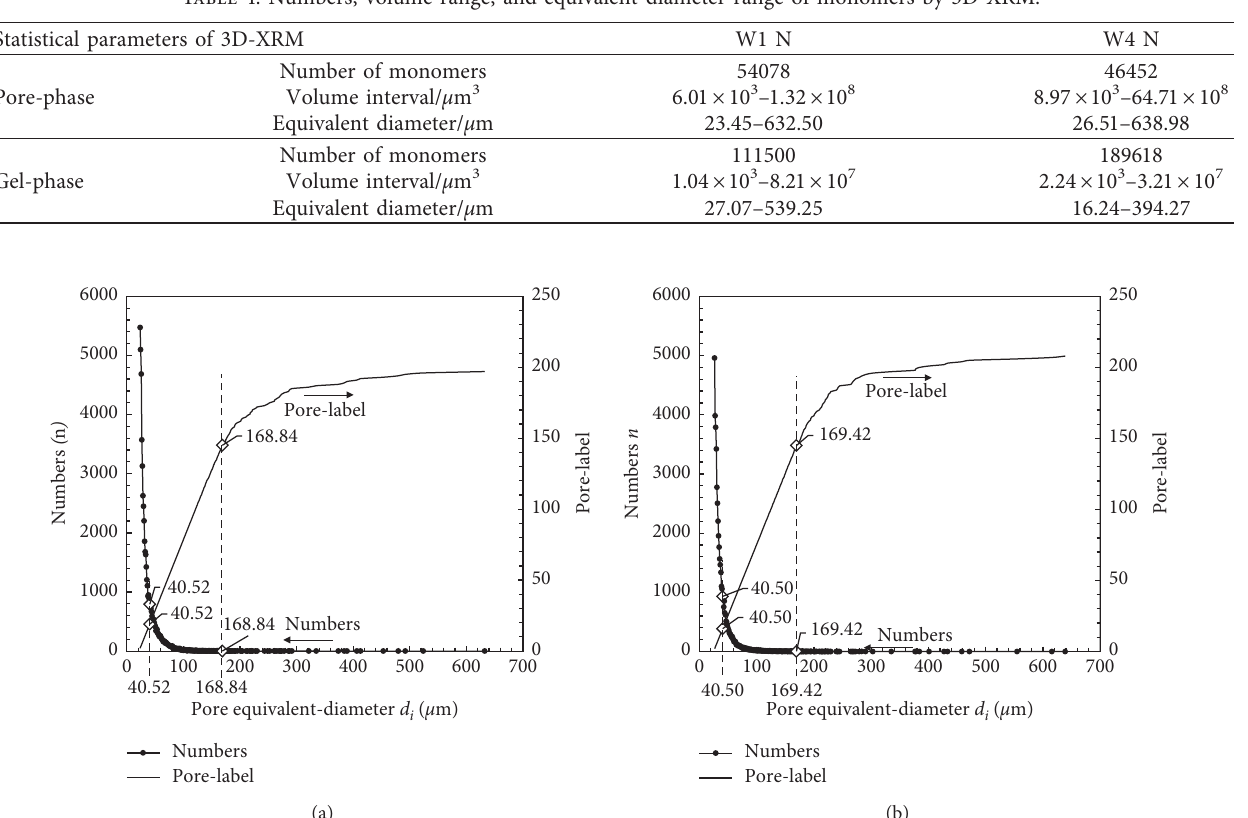
Table 4: Numbers, volume range, and equivalent-diameter range of monomers by 3D-XRM.